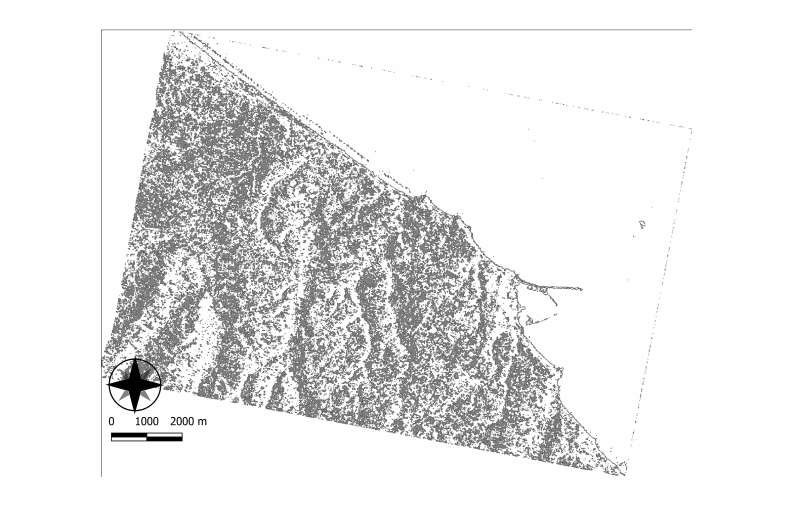
Figure 5. Application of the J-Net Dynamic algorithm on the SAR Sentinel-1 image acquired on 31 December